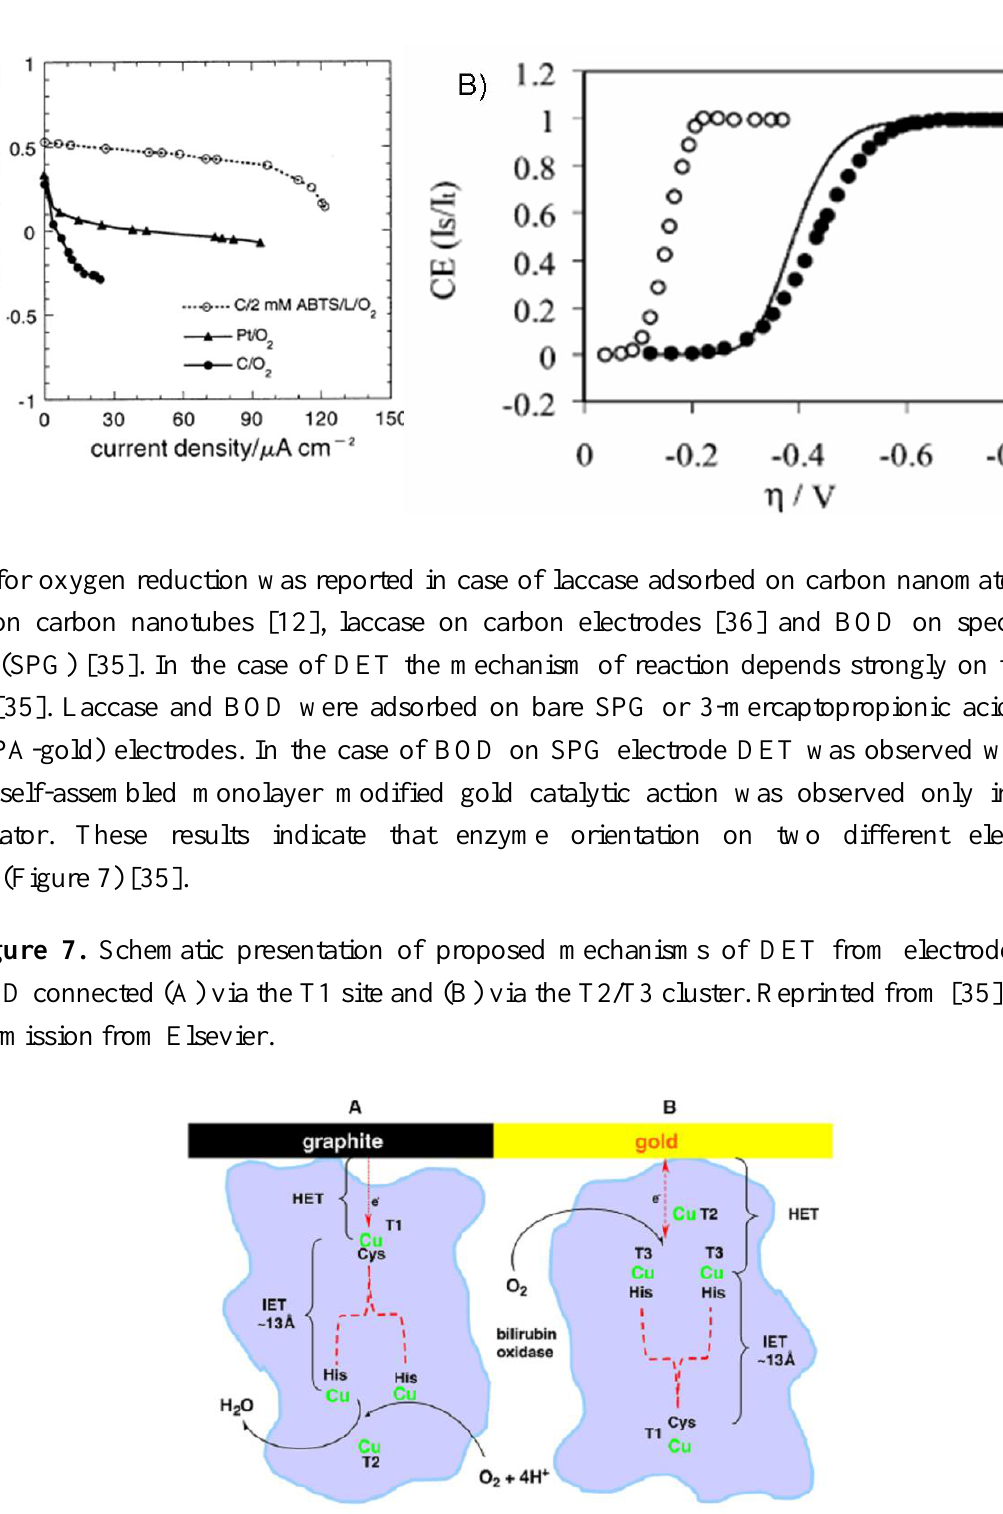
/ I ) on the overpotential (η) in tip S T SO (solid line) and for Pt 2 4